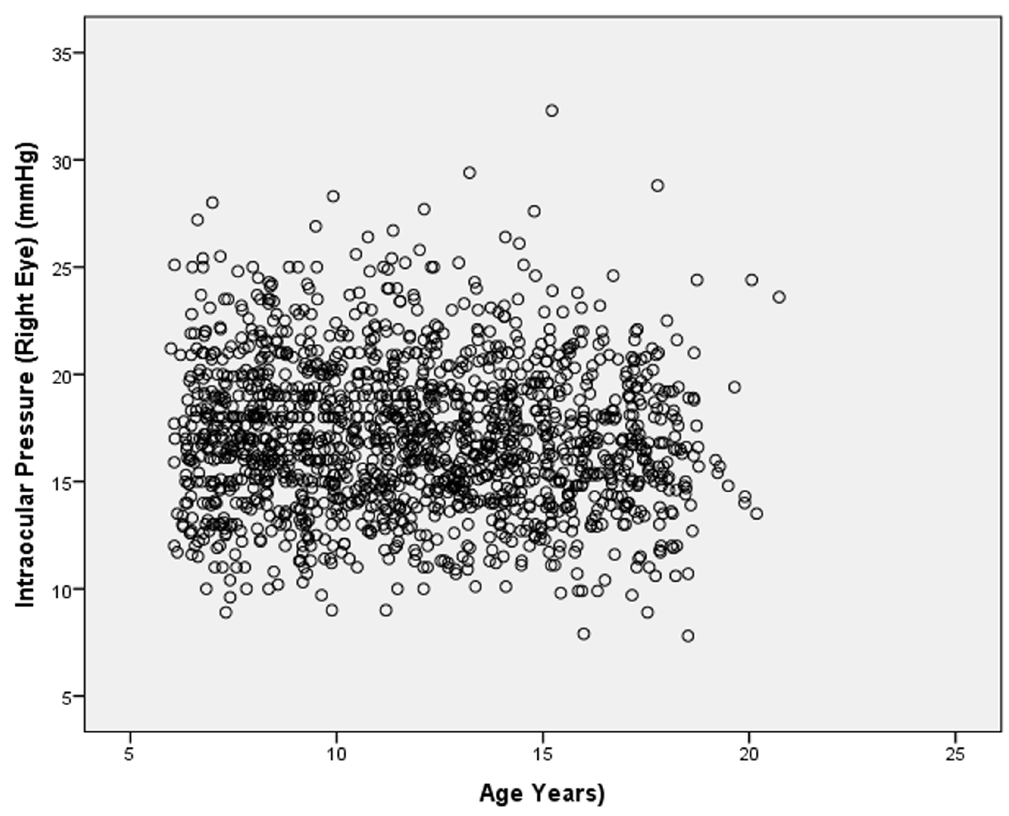
Figure 2. Scattergram Showing the Distribution of Intraocular Pressure and Age in the Gobi Desert Children Eye Study.